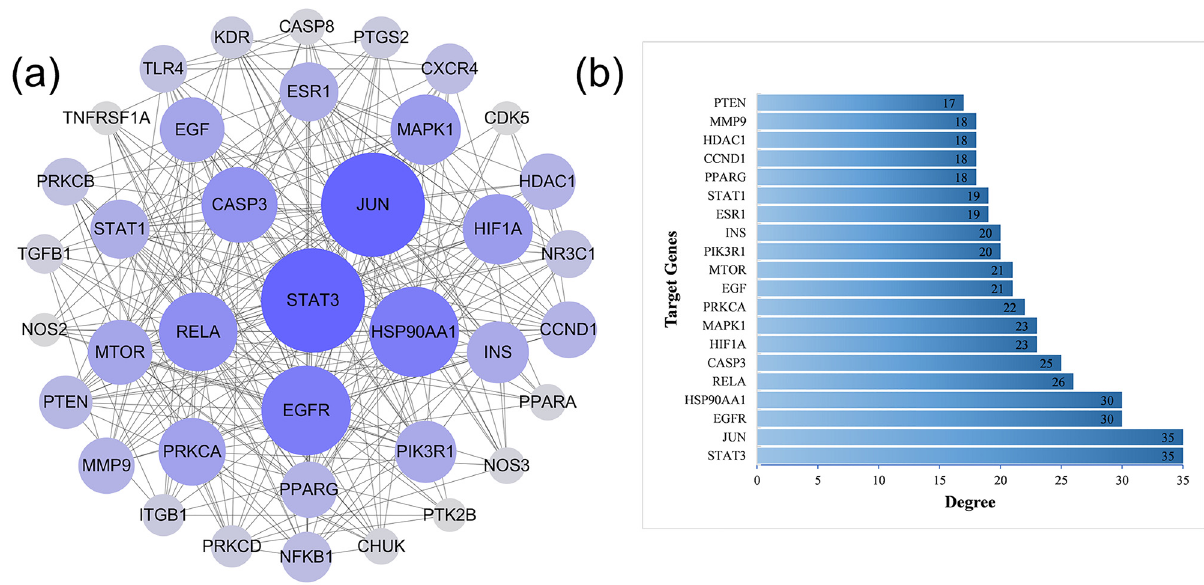
Figure 4: Thirty - eight core targets of C. sinensis for RIRI. ( a ) Thirty - eight core targets between C. sinensis resist RIRI with degree ≥ median, and the larger and the closer to the blue nodes represent the larger degree value. ( b ) Top 20 protein targets sort by